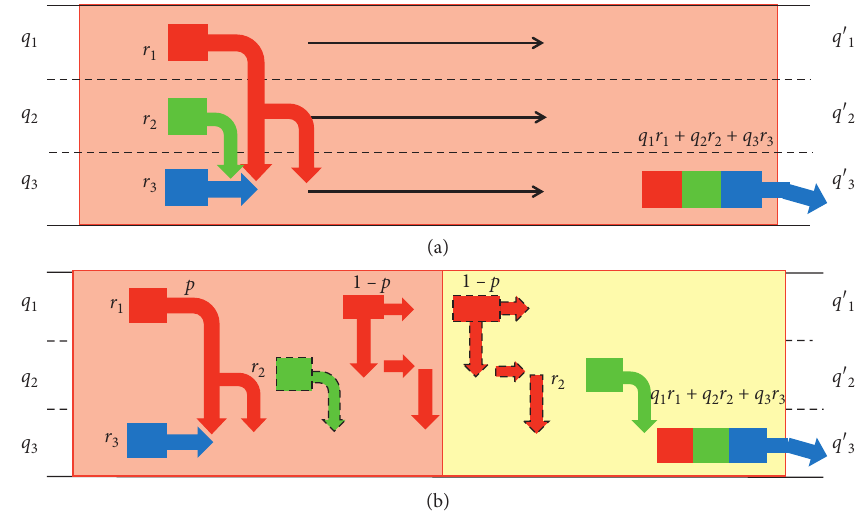
Figure 4: A lane-changing schematic diagram in a segment: (a) unified lane-changing and (b) stepped restriction on the order of lane-changing for these vehicles. Figure 4(a) shows that in a certain lane-changing space, Vehicles change lanes and eventually all vehicles of off-ramp according to the unified order, the vehicle groups change concentrate in the outside lane. Similarly, to reduce the lanes to outside. The vehicles in the inner lanes change lanes congestion that is caused by excessive traffic pressure in the to the outside within the lane-changing space. There is no